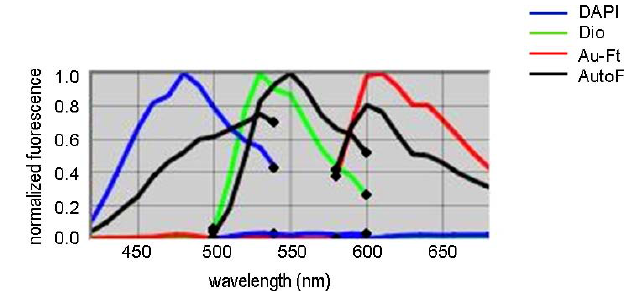
Fig. 2. Fluorescent probe emission spectra and tissue auto- °uorescence data used for spectral deconvolution. Tissue slices labeled with one kind of °uorescent probe were examined via an inverted °uorescence microscope (Olympus IX71